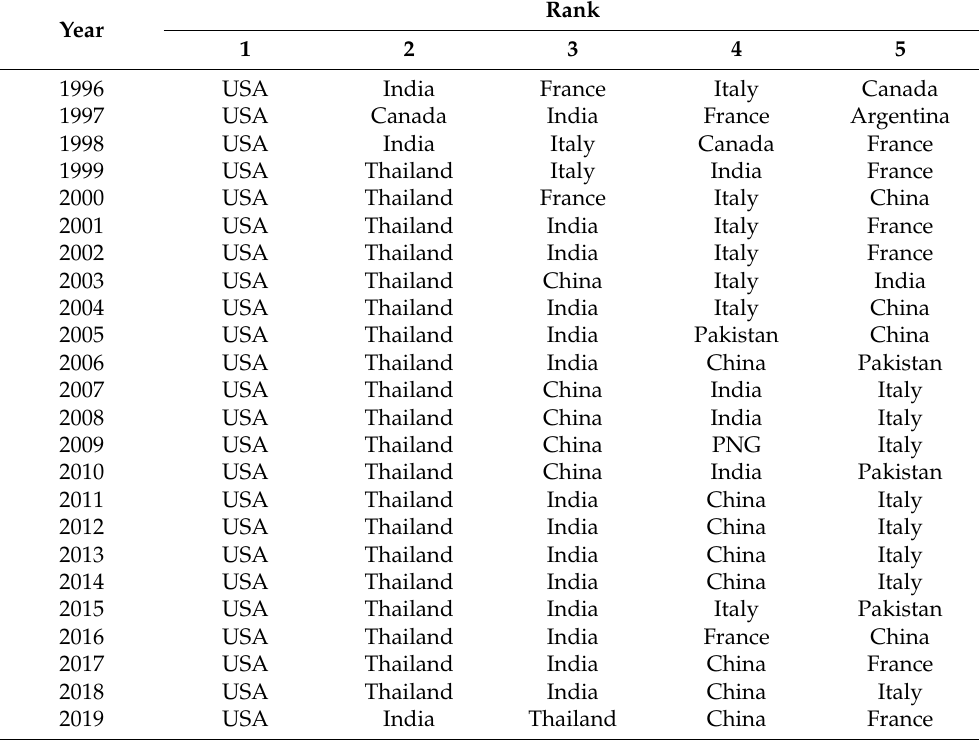
Table A2. The top 5 countries in closeness